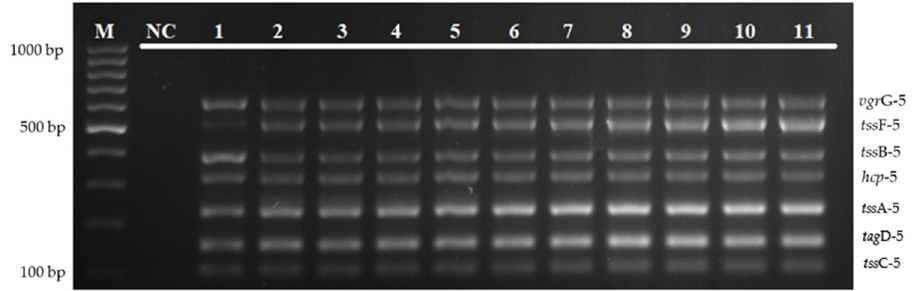
Figure 3. Agarose gel electrophoresis for the optimization of annealing temperature using gradient PCR. The optimization of annealing temperature for the multiplex PCR assay was set up from 52 °C to 62 °C. Lane M: 100 bp DNA ladder; lane NC: negative control; and lanes 1–11: annealing temperature from 52 °C to 62 °C, respectively.